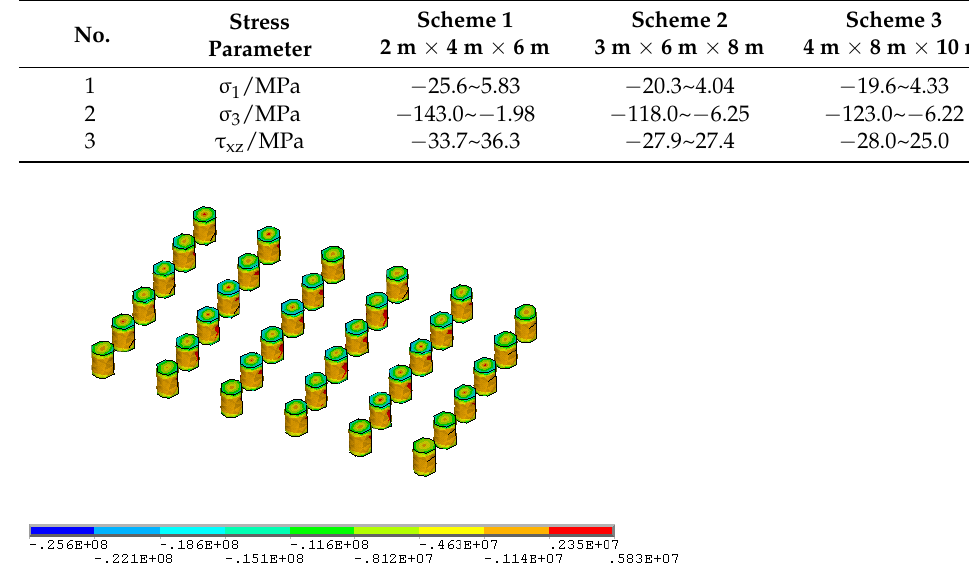
Figure 15. Maximum principal stress distribution of scheme 1 pillars at 1480 mL (parameters of scheme 1: stope height 2.5 m, pillar diameter 2 m, pillar spacing 4 m, pillar row spacing 6 m).